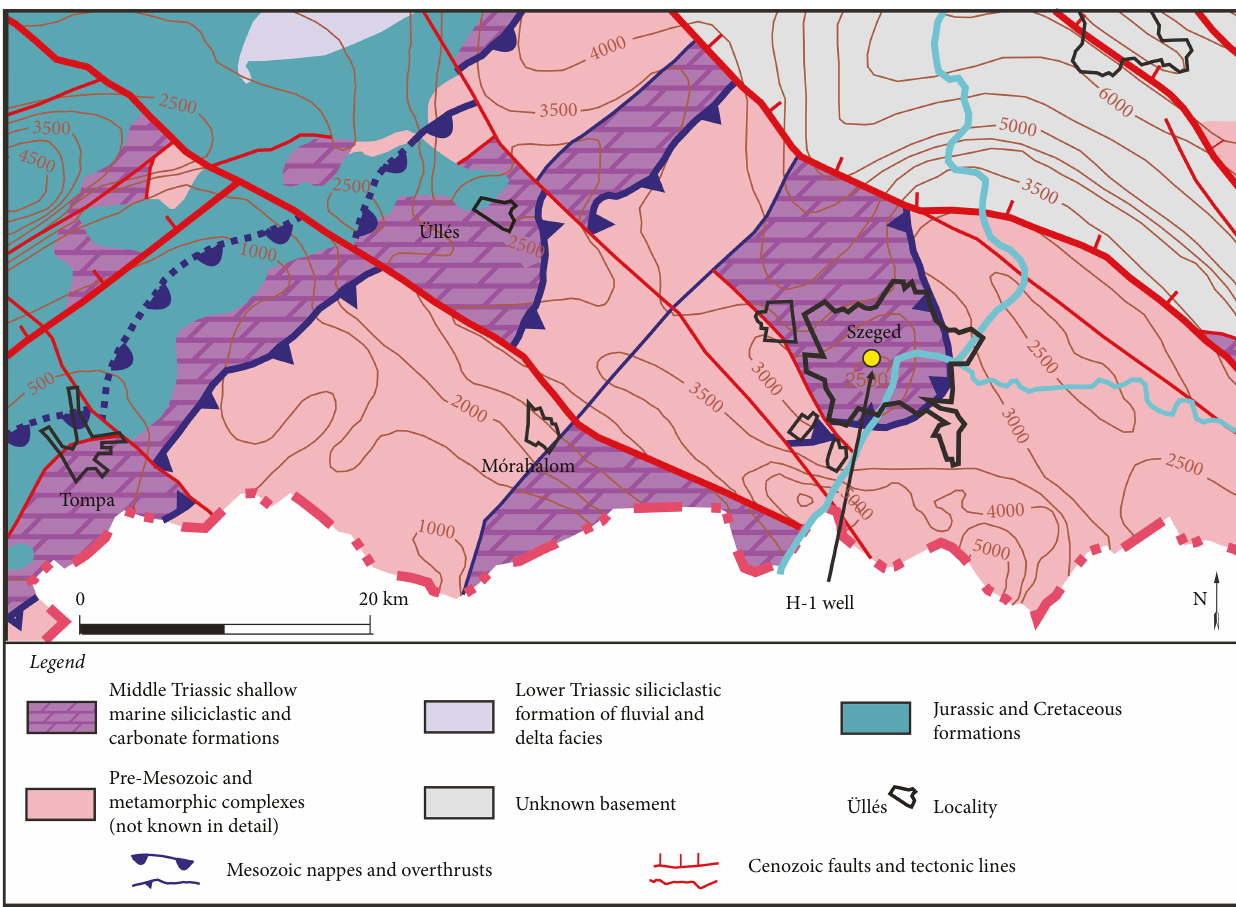
Figure 3: Generalized geological map of the pre-Cenozoic basement of the Szeged area, belonging to the Codru nappe system (Tisza mega- unit), and its surroundings [23, 26, 27]. Isoline numbers are in meters. The close vicinity of the town Szeged (study area) has a nearly basement-high position. Reservoir rock characterization was carried out on core samples from the well H – 1-penetrated Miocene to Pliocene deposits above the